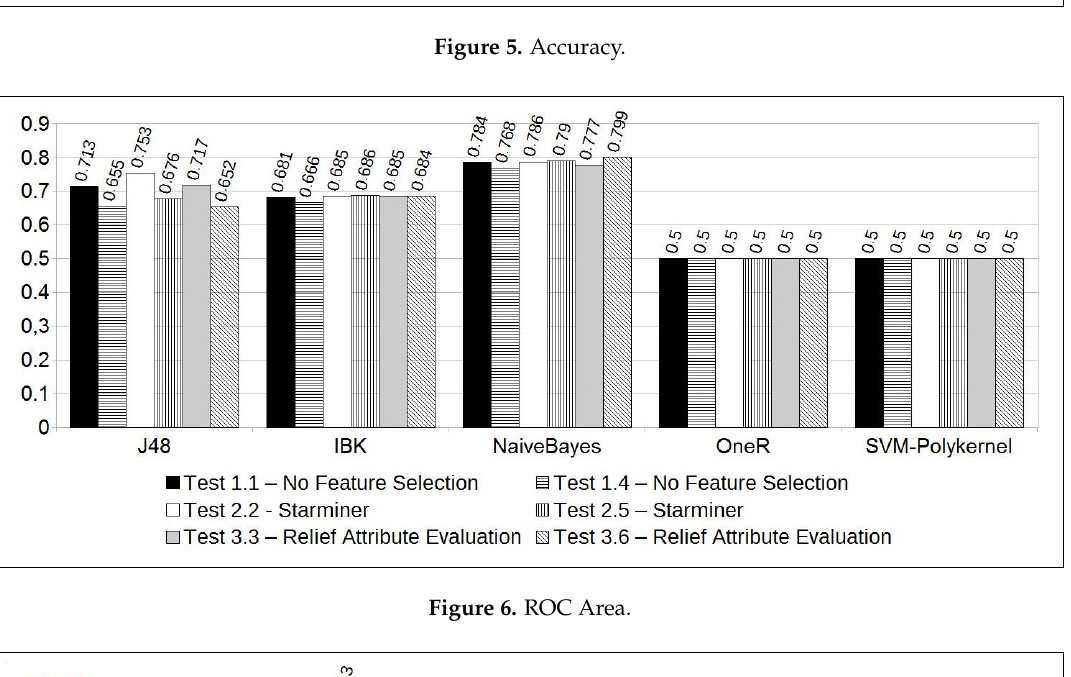
Figure 6. ROC Area.